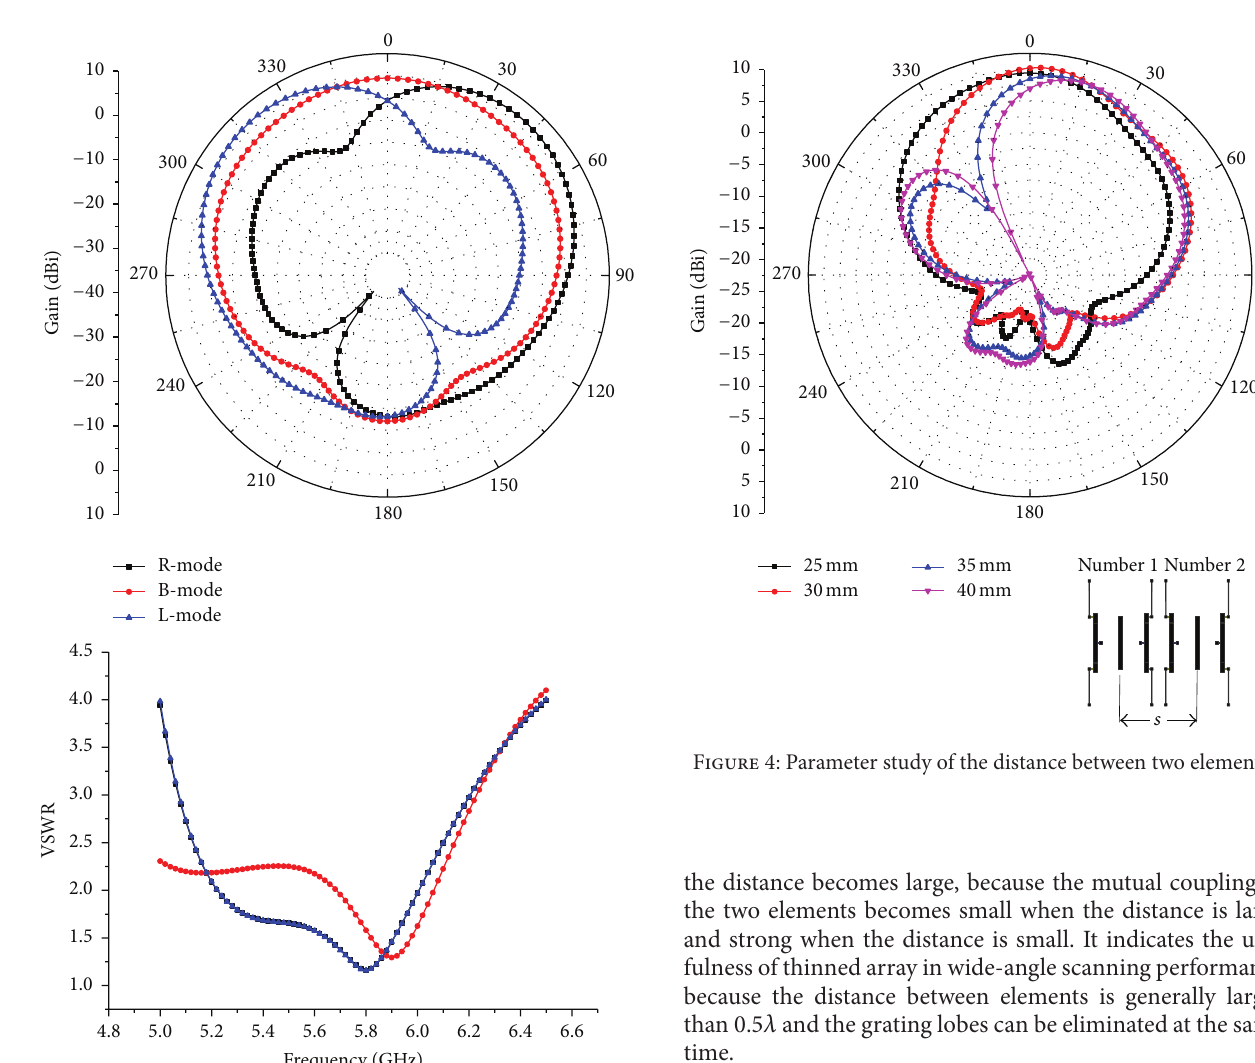
of 0.025 pf. The simulation results can be found in Figure 3. The 3 dB beam width of the antenna can jointly cover an angle in the range of − 75 ∘ ∼ 75 ∘ ; all of the three modes share a common 2 : 1 VSWR bandwidth from 5.68 GHz to 6 GHz.